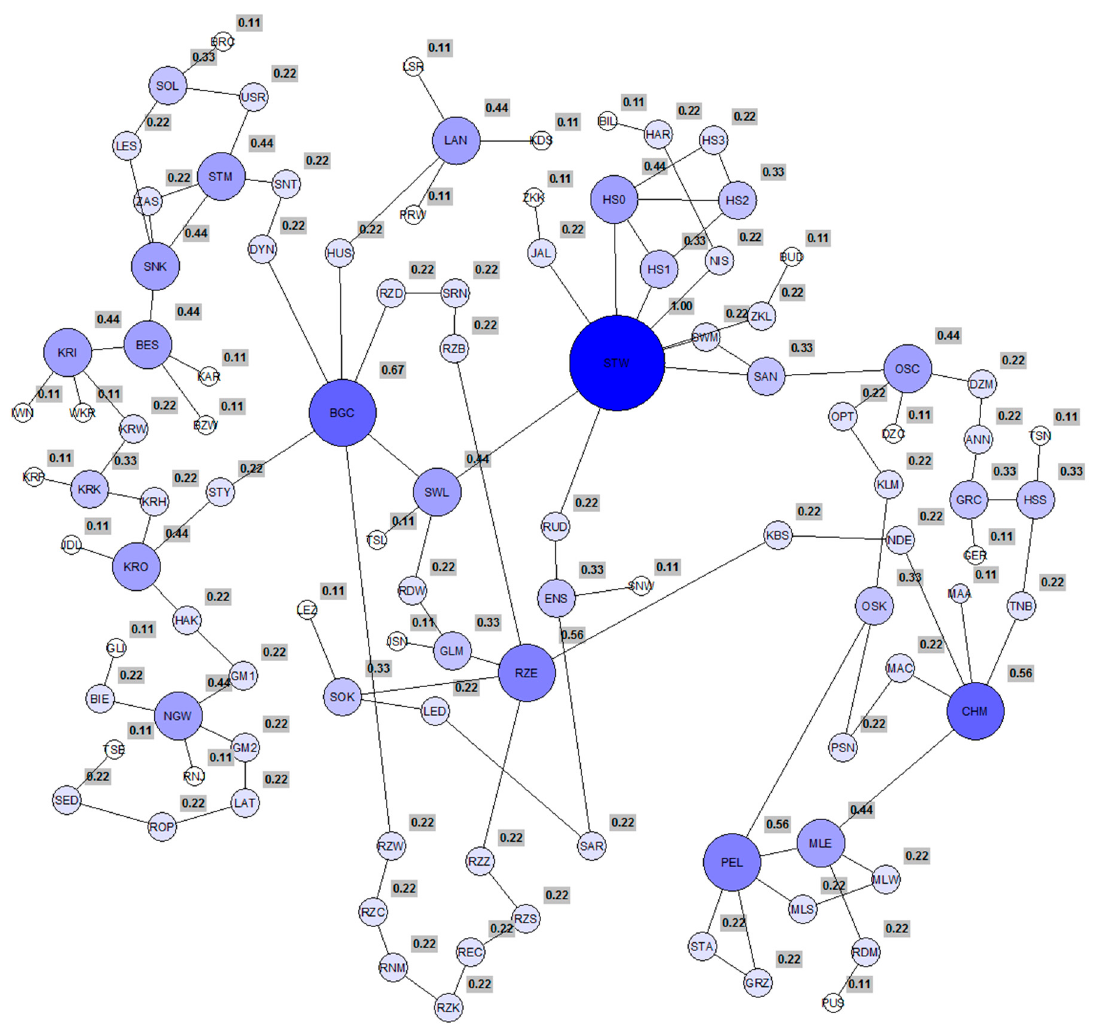
Figure 3. Analysis of graph centrality for the original form of the examined network. The density of blue color and the size of node refers to the node degree. The numbers refer to the fraction of the node STW degree.